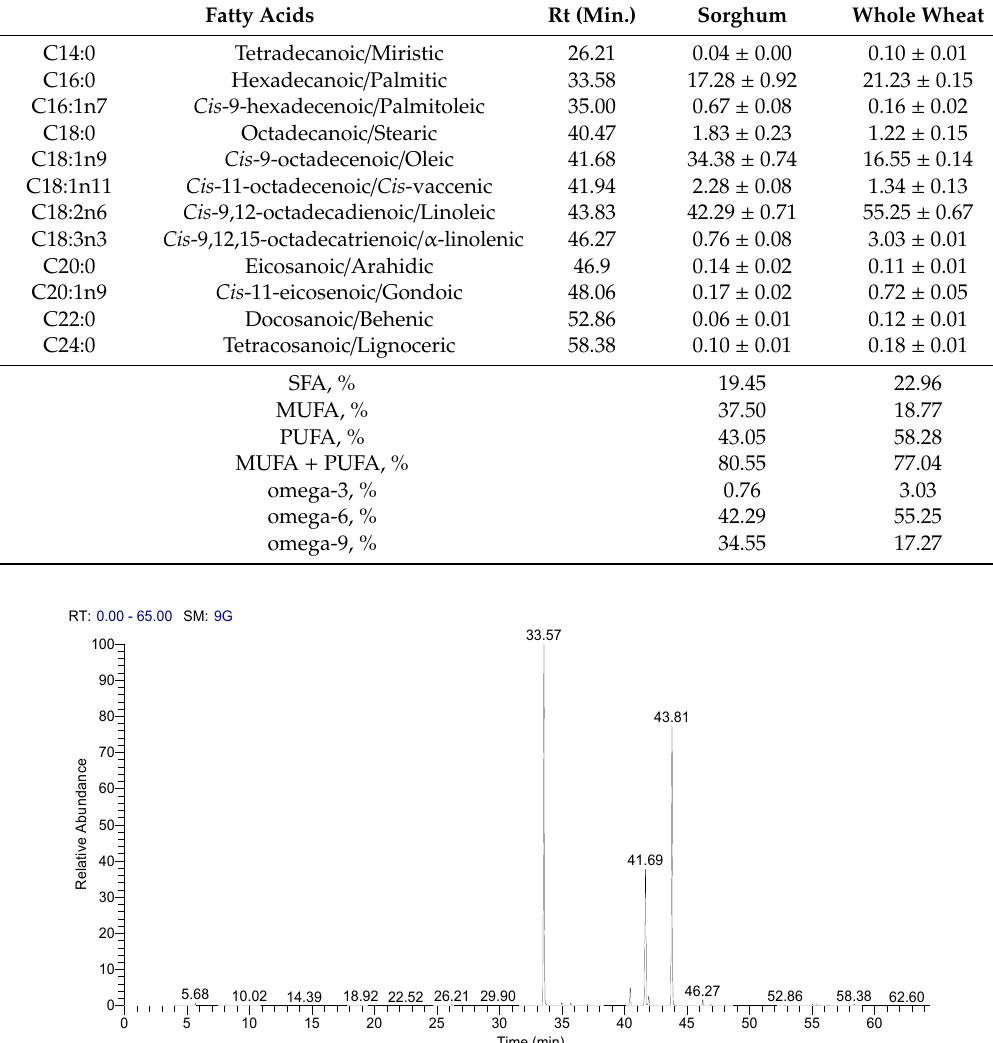
Table 5. Fatty acid composition of seed oil of whole wheat and sorghum seed.